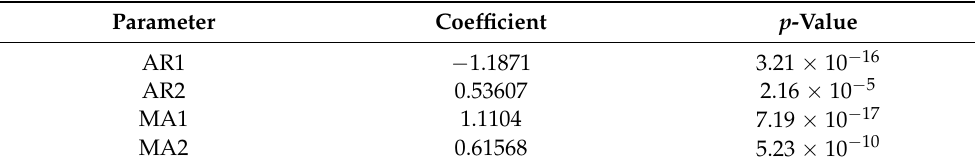
Table 2. Fitting results for ARIMA model with a bandwidth of 8GHz in an indoor scenario. Parameter